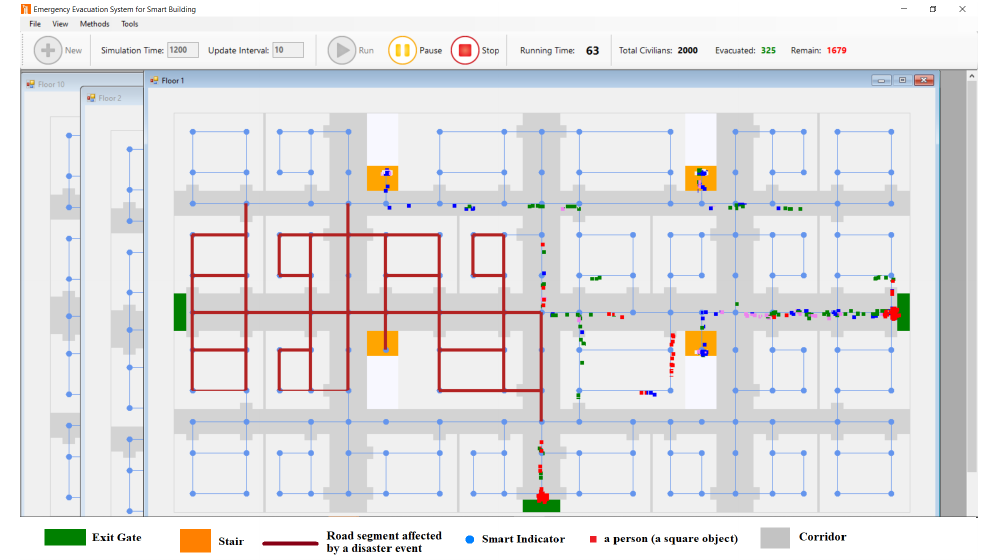
Figure 3. An Evacuation Guidance Simulator.